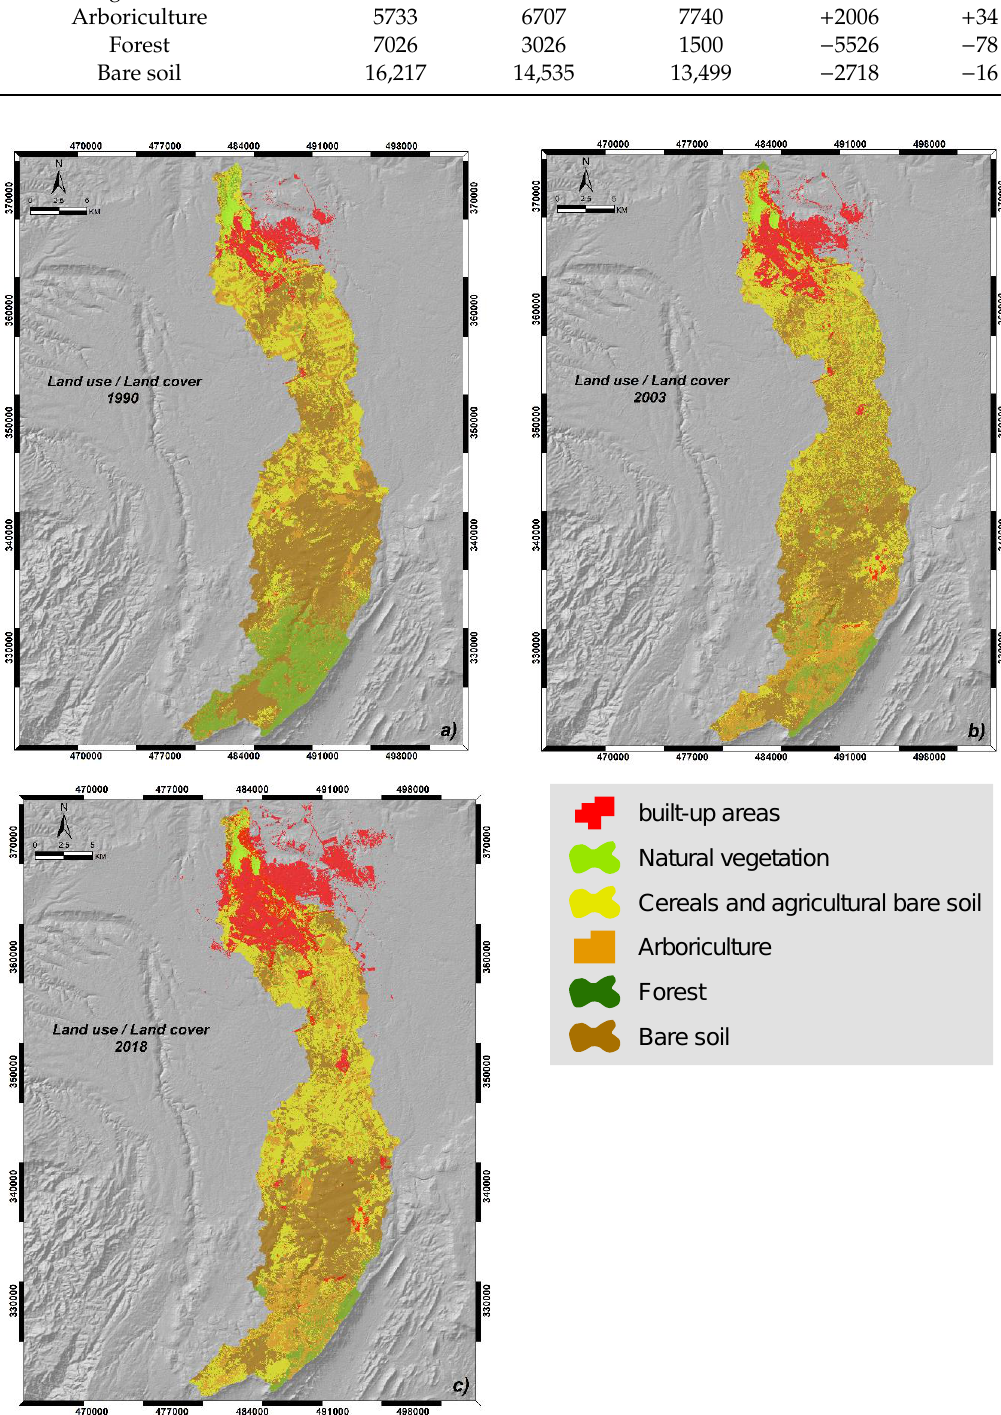
Figure 4. LULC map, ( a ) LULC map for 1990, ( b ) LULC map for 2003 and ( c ) LULC map for 2018.